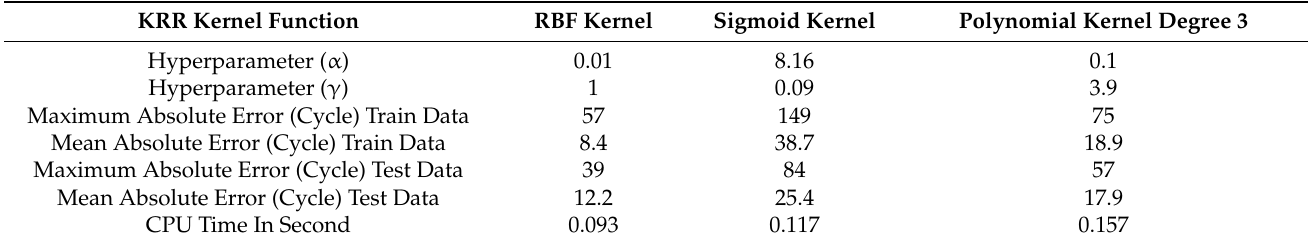
Table 16. Comparison results of FEM and KRR models on 576 training datasets.